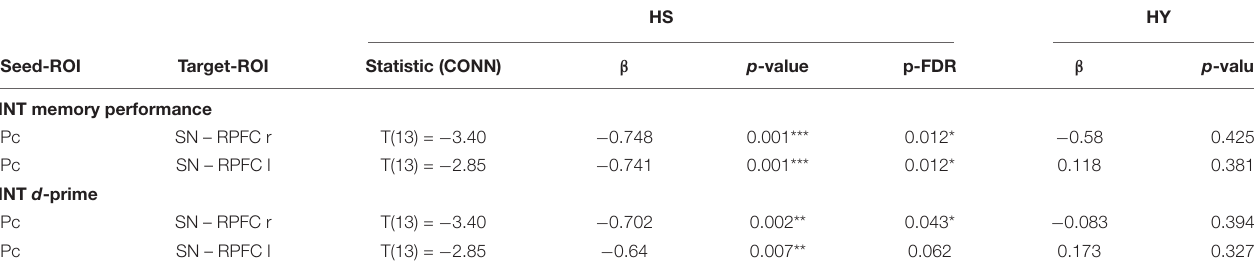
TABLE 8 | Functional connectivity during post-encoding rest predicting memory performance and d -prime of HS in the interference condition. HS HY